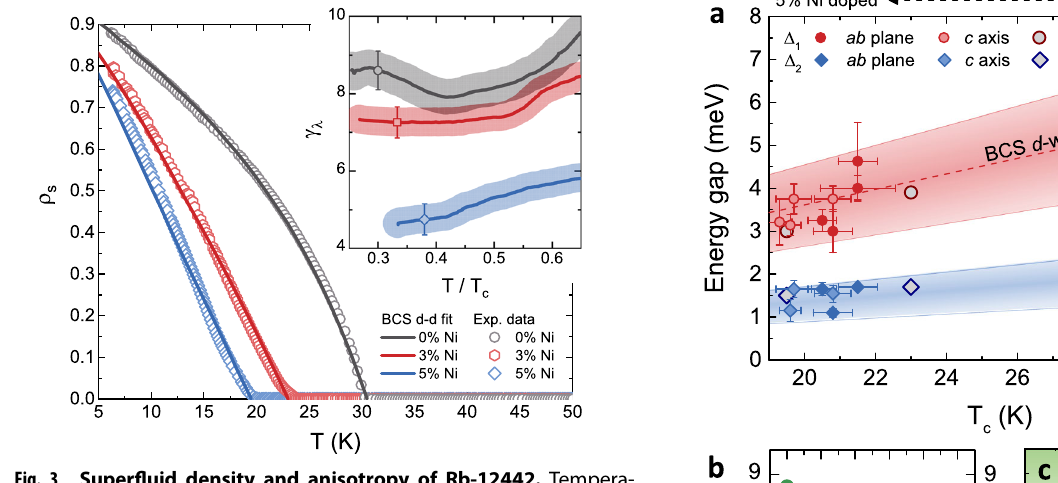
Fig. 3 Super fl uid density and anisotropy of Rb-12442. Tempera- ture dependence of the normalized super fl uid density measured with the CPWR technique on single crystals with x = 0, 0.03 and 0.05 (symbols) and their d − d BCS fi ts (lines). Inset shows the London penetration depth anisotropy ( γ λ ) as a function of the normalized temperature for the three doping levels. The shaded bands around the lines represent the error of the reported γ λ values (an illustrative error bar is also shown, for a single point of each curve), arising from the uncertainties of each λ measurement and their propagation.